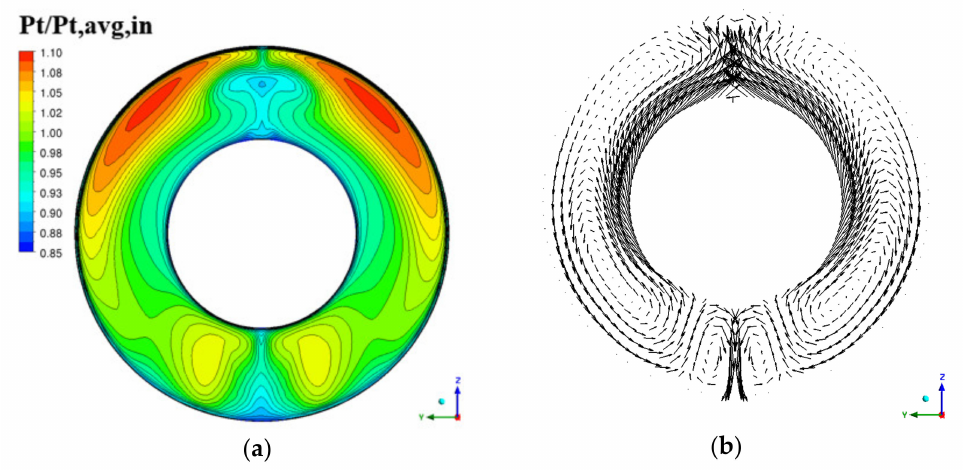
Figure 3. Inlet boundary plane. ( a ) Total pressure coefficient; ( b ) in-plane swirl direction